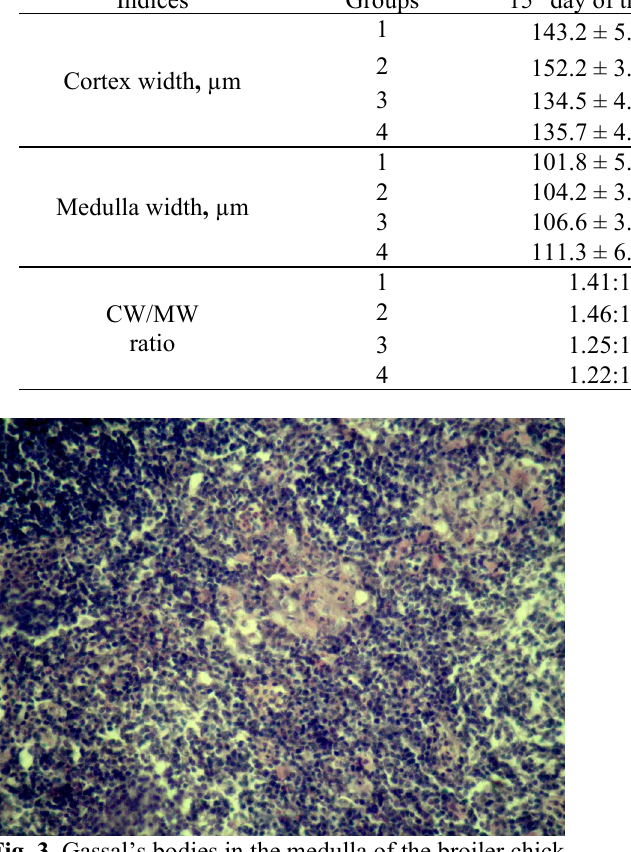
Fig. 3. Gassal’s bodies in the medulla of the broiler chick- en’s thymic lobule, the 1 st group, the 30 th day of the test.